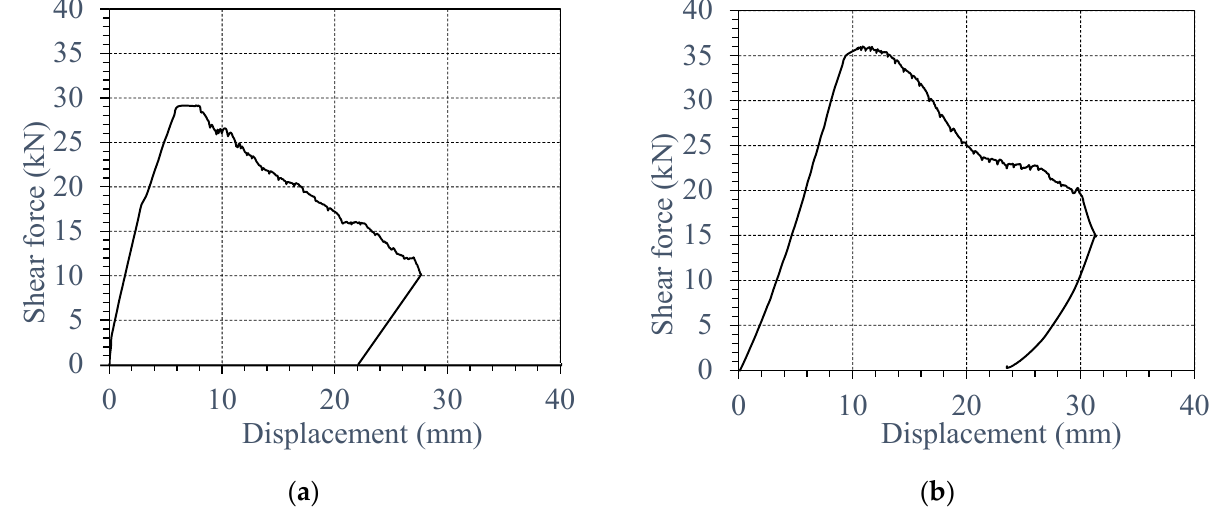
Figure 12. Failure of specimens. ( a ) DS-O; ( b ) CCRS-O; ( c ) Crack patterns for specimen CCRS-O.